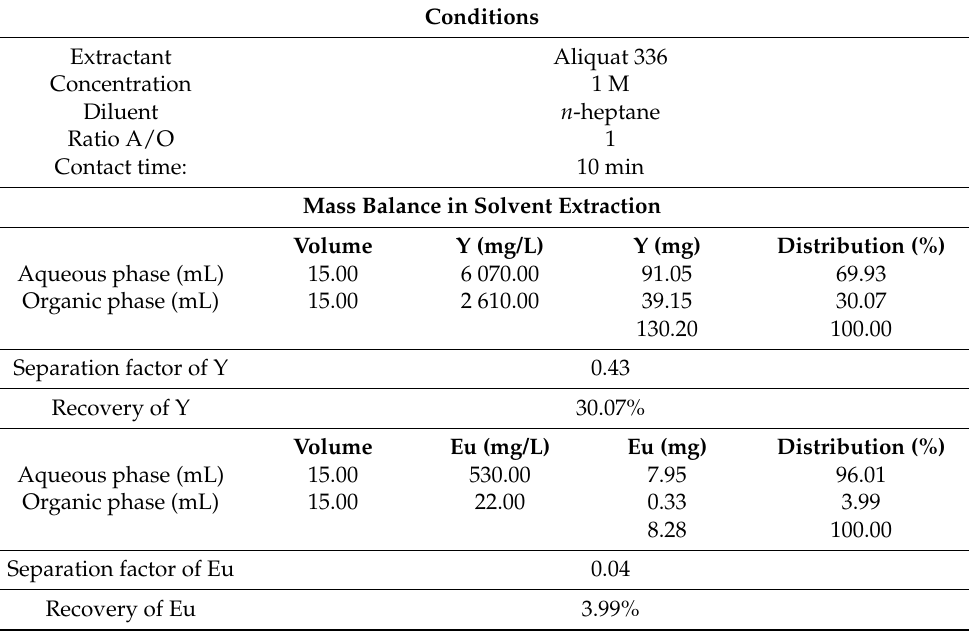
Table A3. Europium and yttrium recovery and separation factor with Aliquat